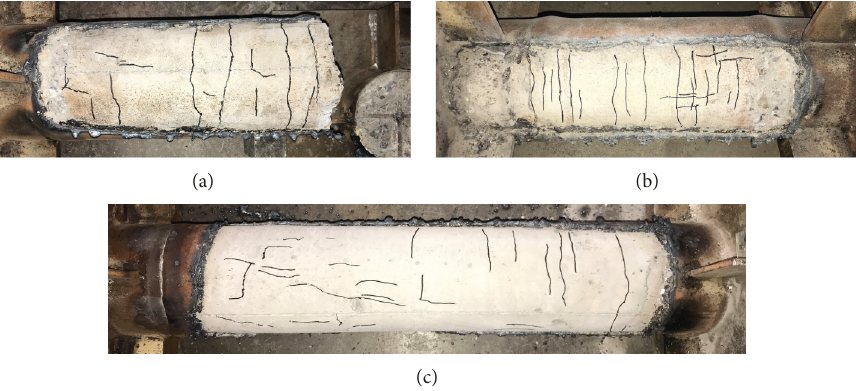
Figure 5: Core concrete in failure. (a) CFST-5; (b) CDST-10; (c)